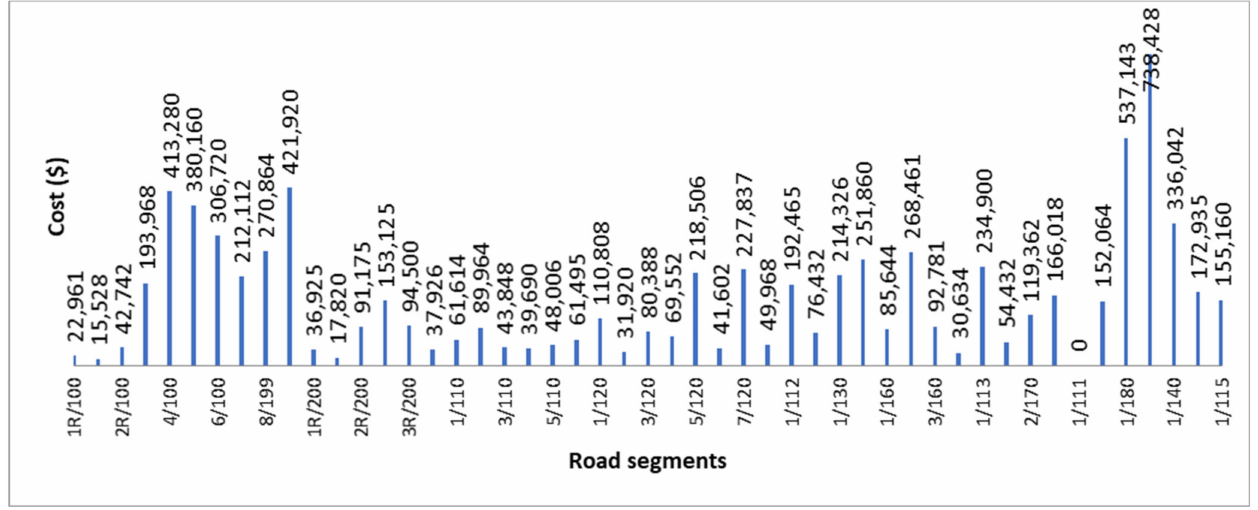
Figure 10. The maintenance cost for selected